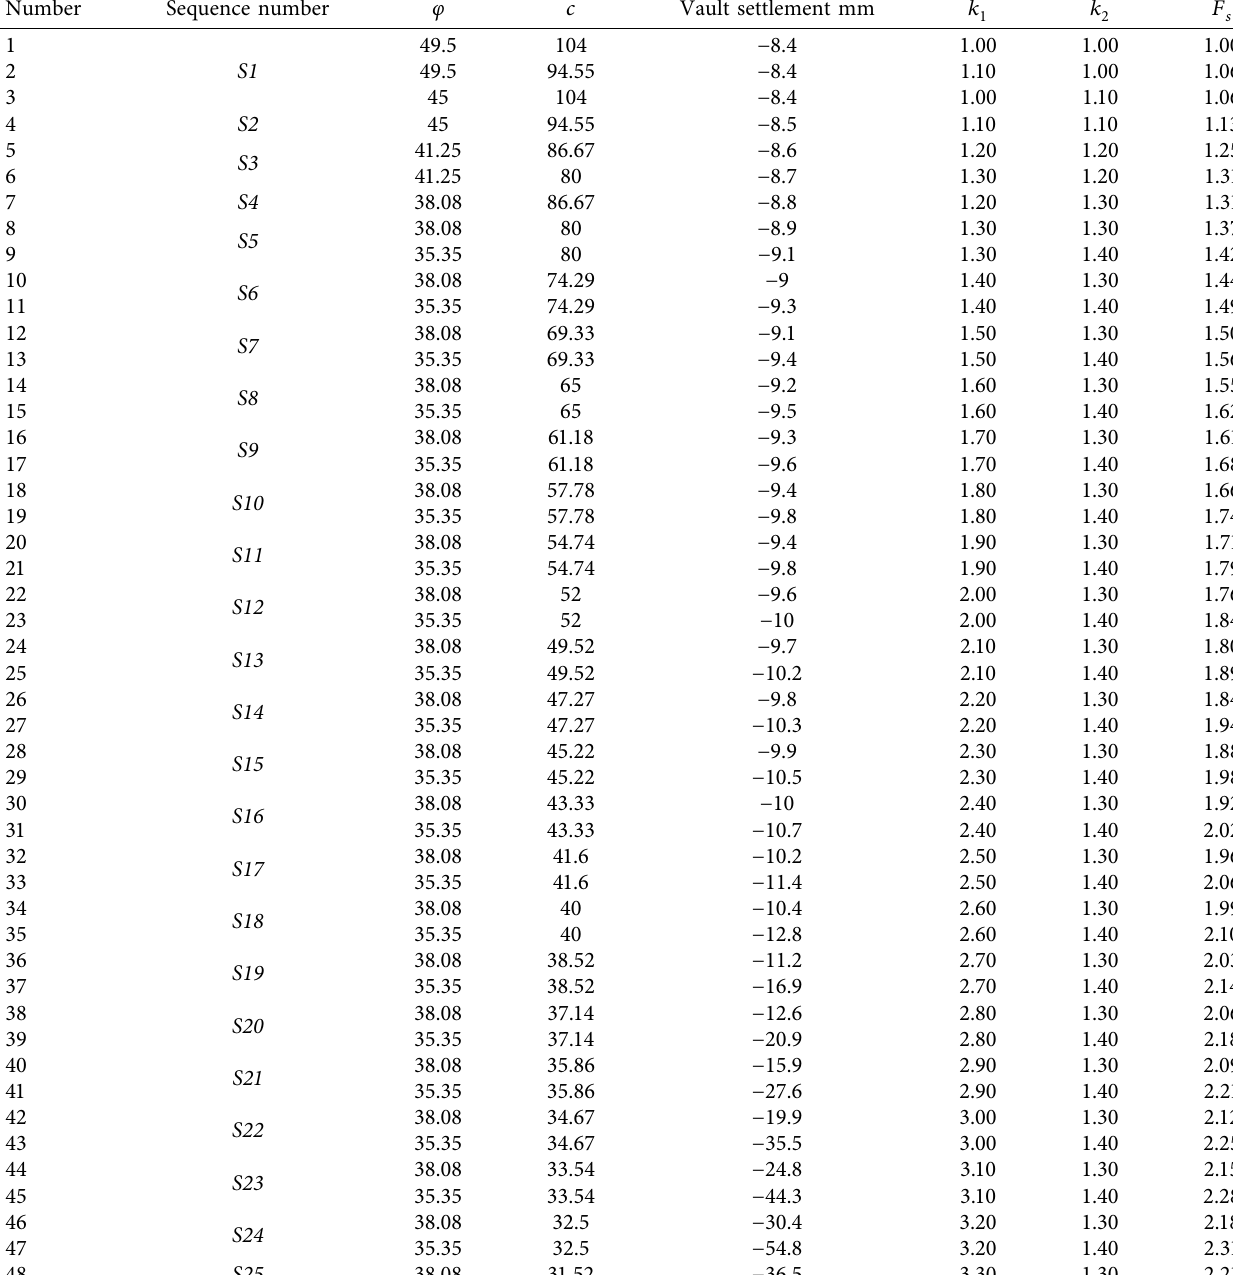
Table 6: Reduction ratio equal to 0.1.